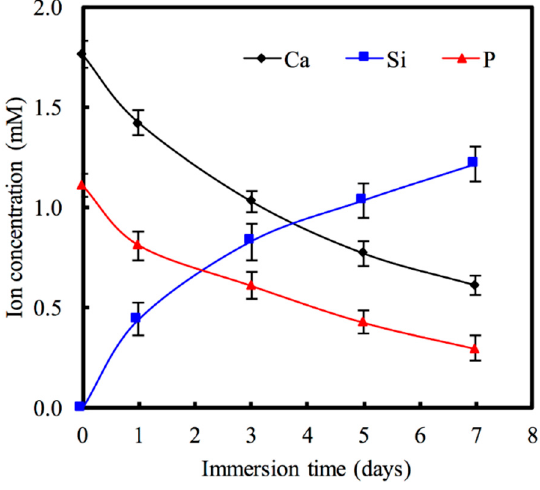
Figure 3. The change of Ca, Si, and P concentrations of PBS with MCS nanoparticles for various days.